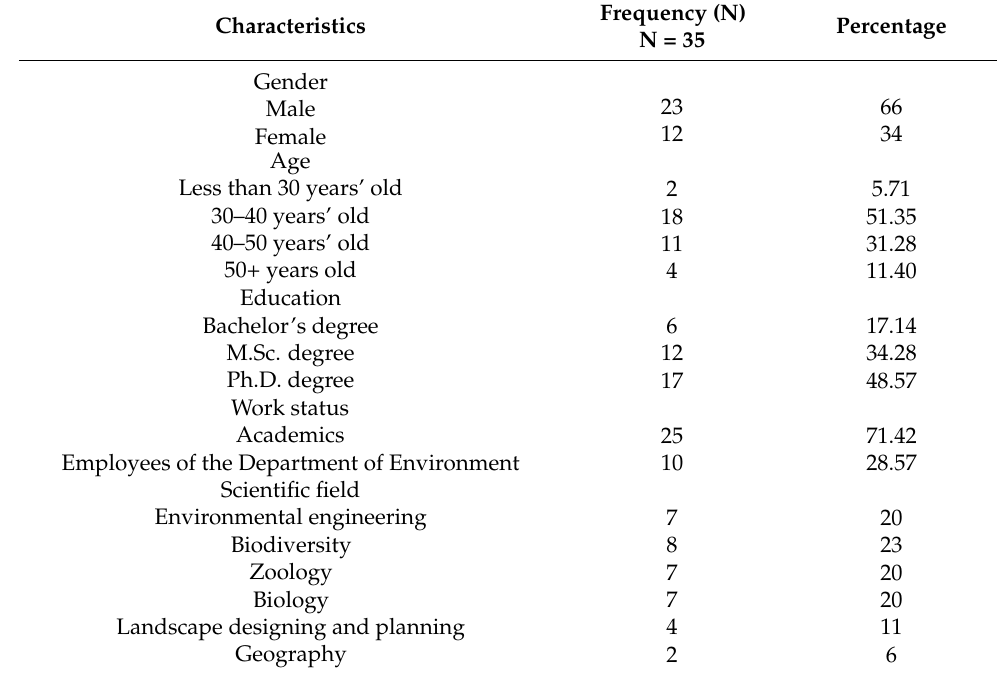
Table 9. Socio-demographic profile of the respondents participating in the Delphi study component to assess indicators affected by ecological risk in two Protected Areas in the Tehran province, Iran.